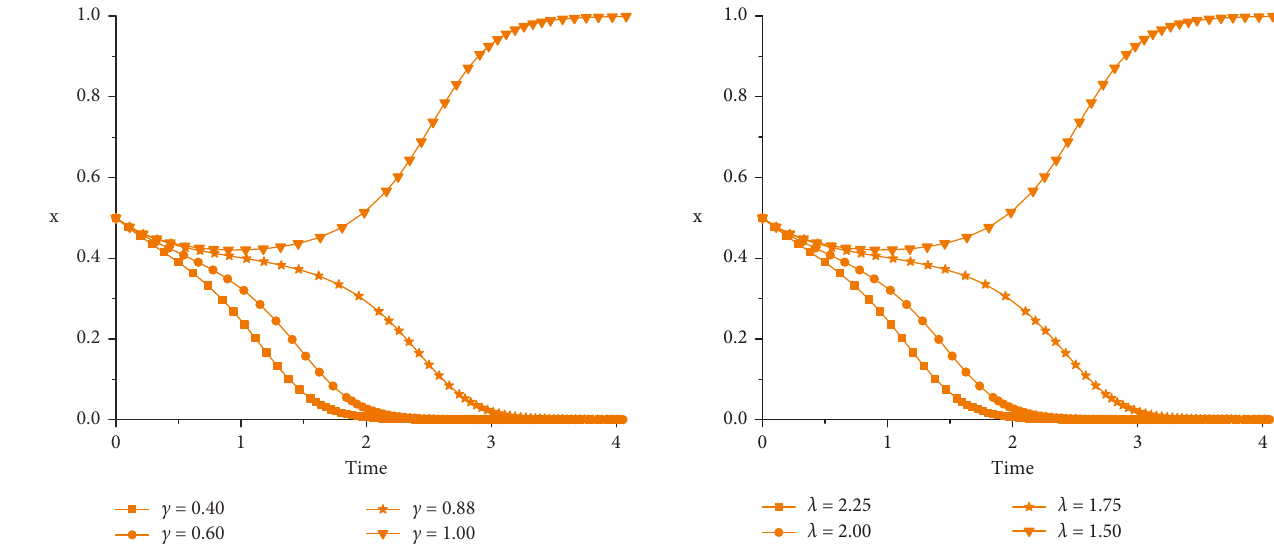
Figure 16: Impact of loss aversion coefficient on enterprise 1.